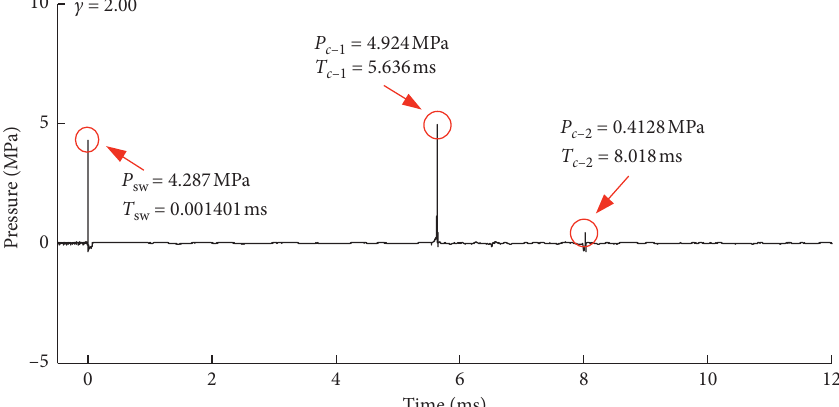
Figure 38: Pressure-time diagram of the first and second cycles of the spark-generated bubble load for c � the wall above it vertically, which causes the bubble to move vertically up during the second cycle. This displacement makes the distance between the bubble collapse position and the bottom of the Hopkinson bar